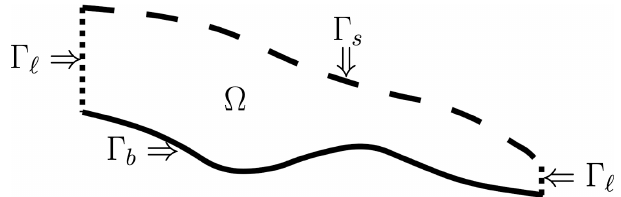
Figure 7. An (x 1 ,x 3 ) cross section of the three-dimensional domain (cid:127) occupied by an ice sheet and the boundary segments defined in Eq.